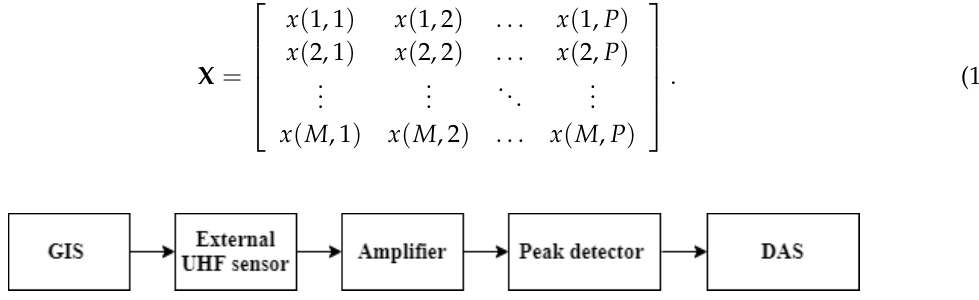
Figure 1. Block diagram of the partial discharge (PD) monitoring